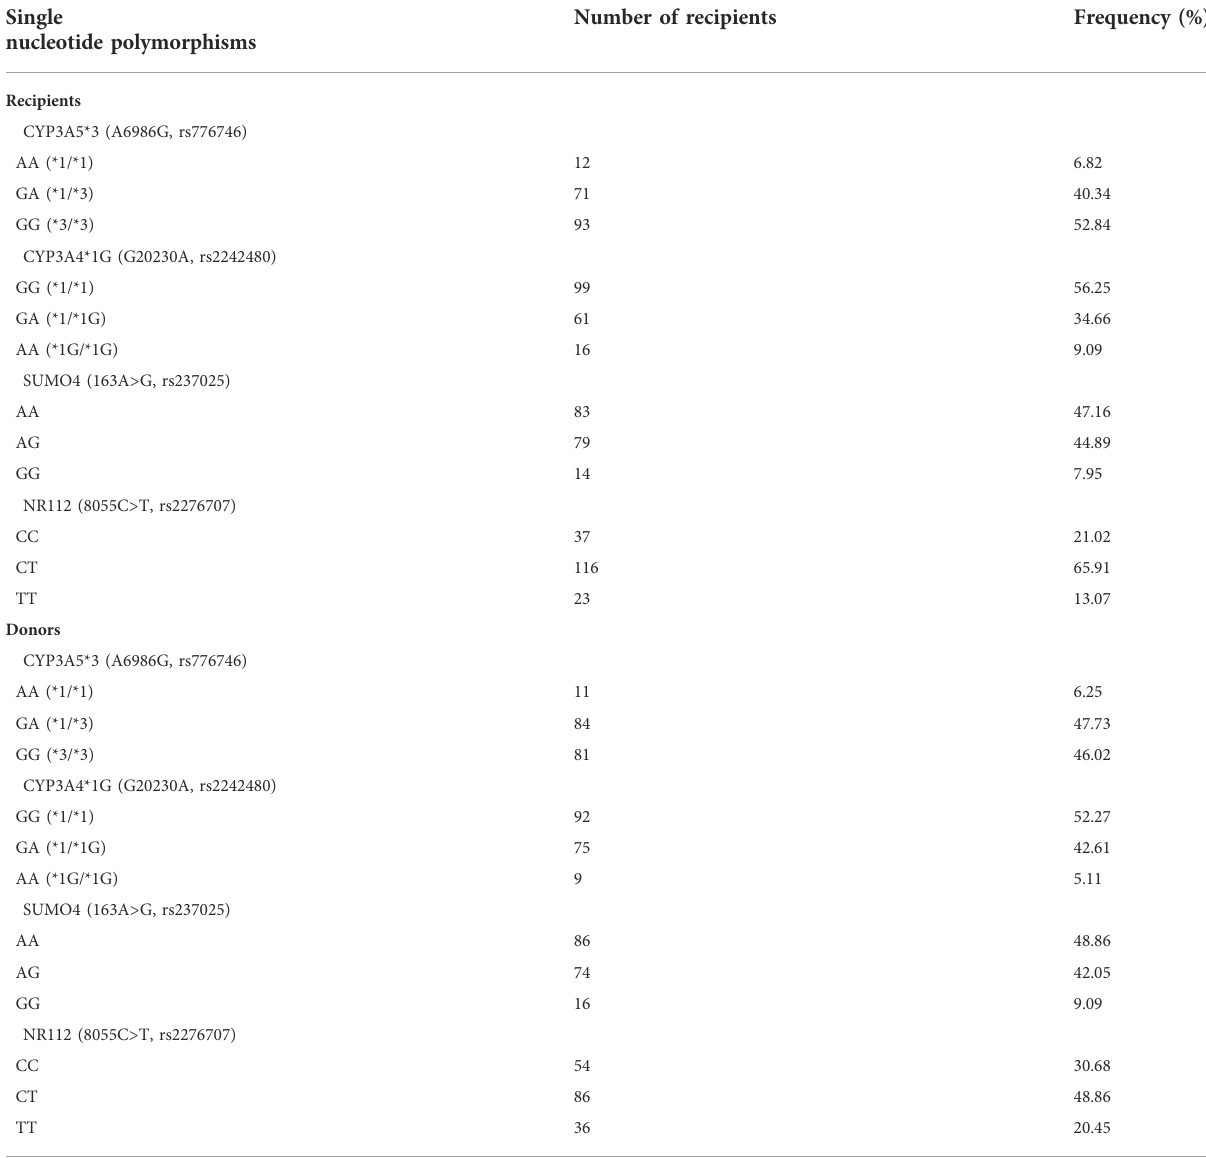
TABLE 2 Allele frequencies of single nucleotide polymorphisms in CYP3A5*3, CYP3A4, SUMO4, and NR112 genes of the development dataset. Single nucleotide